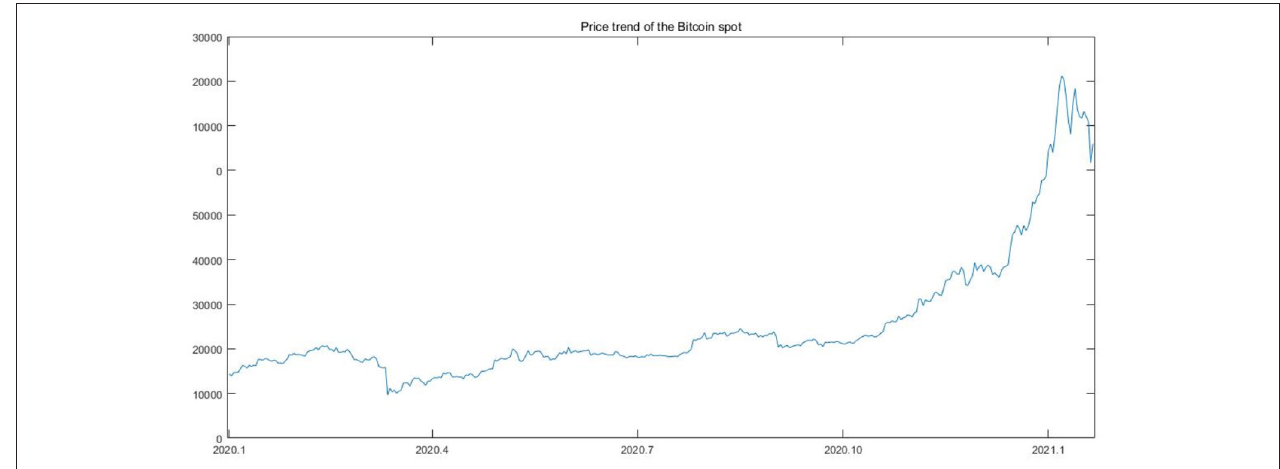
FIGURE 1 | Price trend of the Bitcoin market from 2020 to